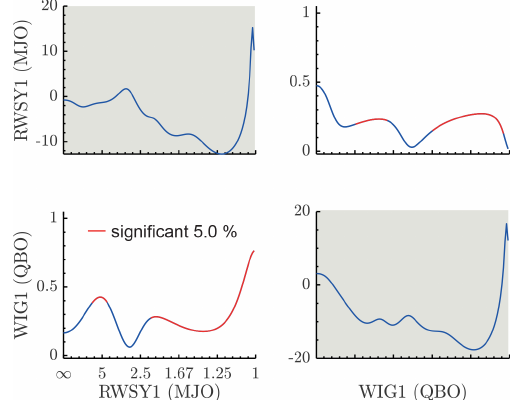
Figure 8. PDC analysis of the interaction of symmetric Rossby modes (meridional index 1, denoted by RWSY1) and westward gravity modes (WIG1) at the slow timescale (periods given in years). Important interactions are found on annual to interannual timescales. Figure conventions are the same as in Fig. 4.